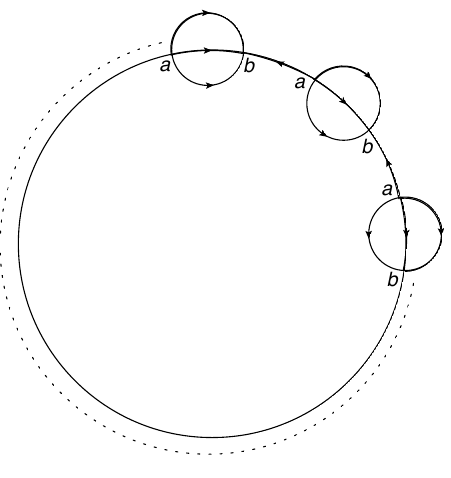
Figure 4 . Circle diagram: a, b represents respectively insertions of , (cid:22) . Direction of arrow is from to (cid:22) . The diagram is drawn for q =